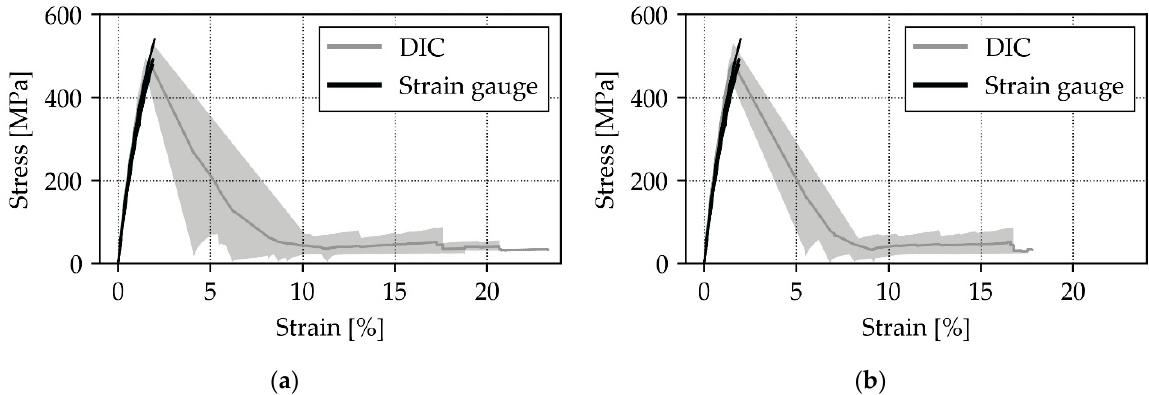
Figure 5. ( a ) Front view DIC and strain gauge comparison for a 0° oriented compression-loaded laminate.; ( b ) side view DIC and strain gauge comparison for a 0° oriented compression-loaded laminate.